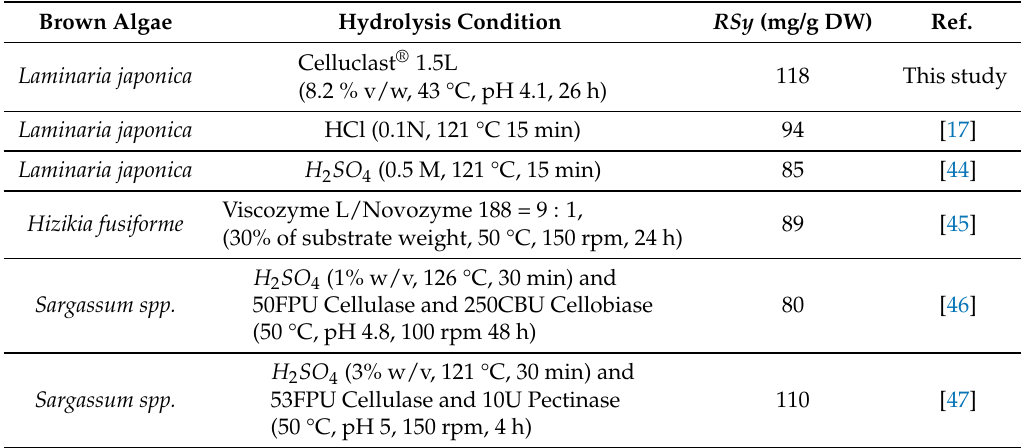
Table 5. Comparison of hydrolysis conditions and their reducing sugar (RS) yields. Brown